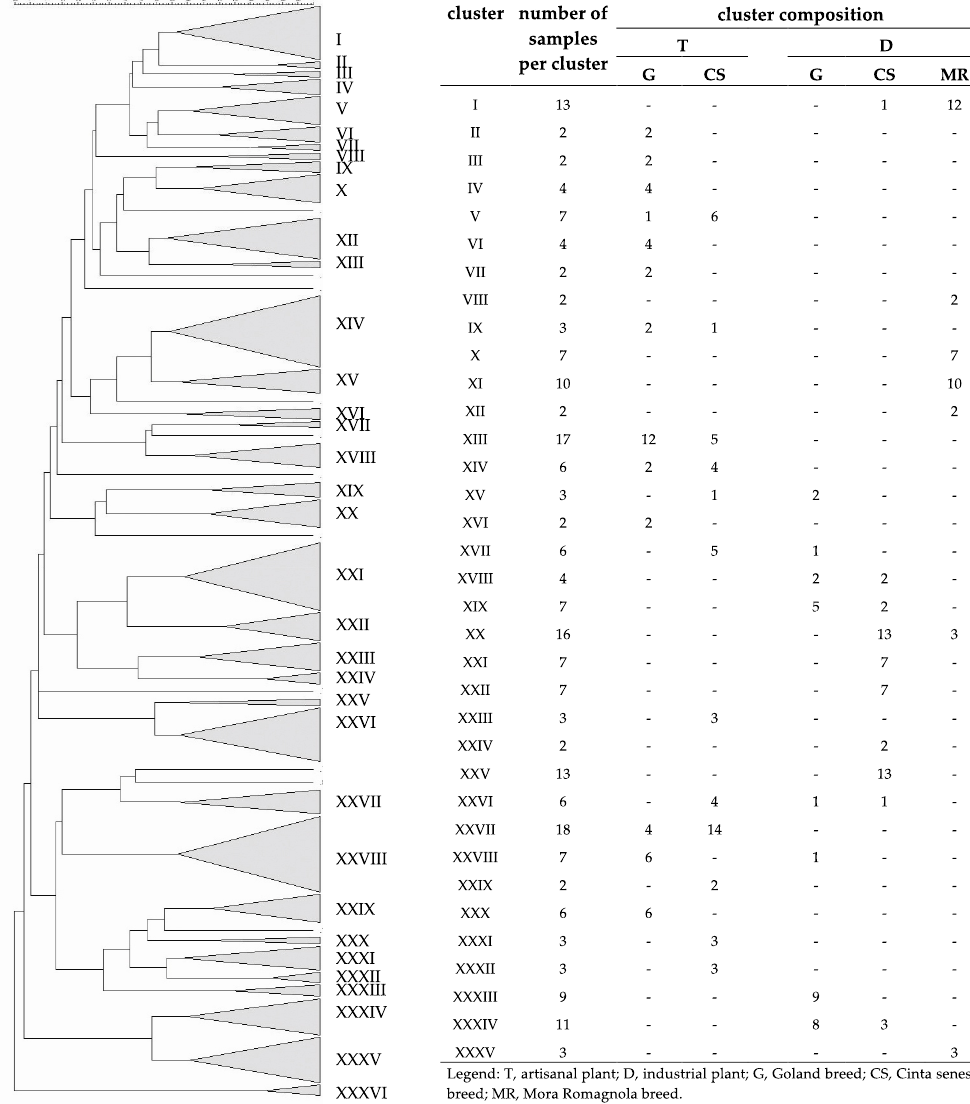
Figure 3. Cluster analysis using Pearson product–moment correlation coefficients and unweighted pair group method using an arithmetic average (UPGMA) of the profiles obtained from the fingerprinting analysis of the different fermentations. A similarity coefficient of 53% was arbitrarily chosen. Identified clusters are indicated with roman numerals. Cluster composition is defined in the table within the figure.